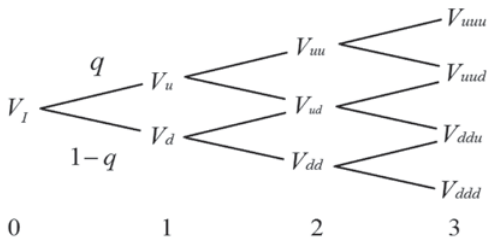
Figure 1. Binomial tree of underlying asset, V